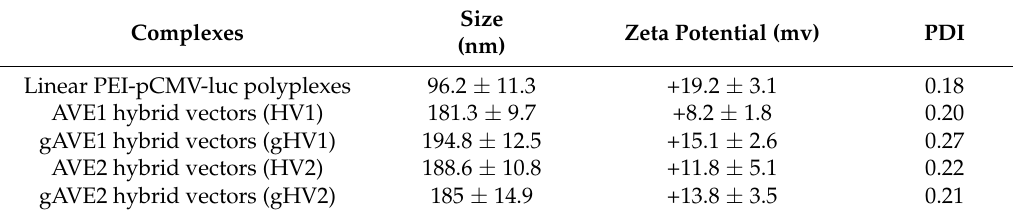
Table 2. Hydrodynamic diameter (by intensity) and zeta potential of the liposomal formulations. Size Complexes